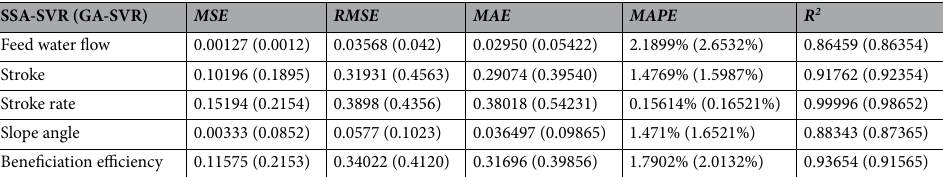
Table 2. Simulation result of the models.